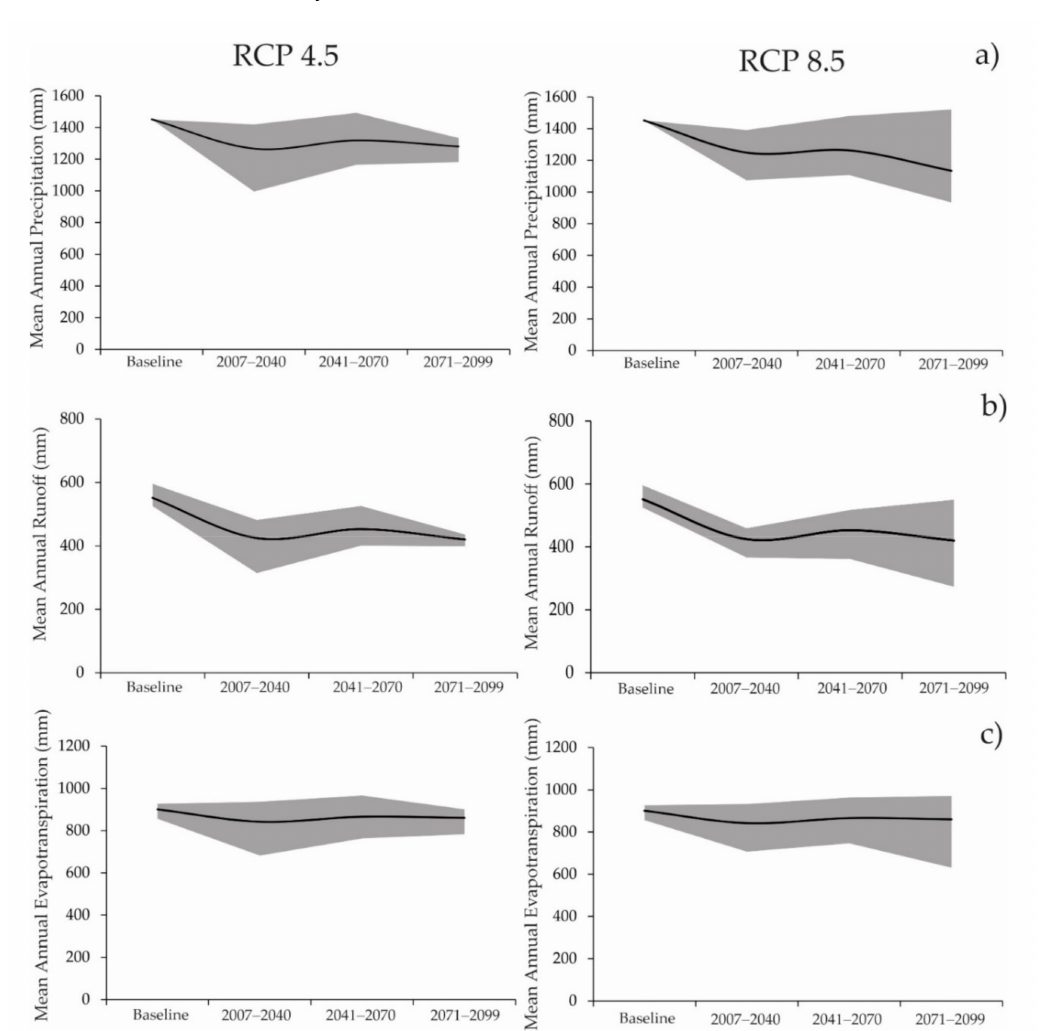
Figure 7. Average annual water balance components for the baseline and time slices simulated by the LASH model forced by the RCMs for the GRB-Furnas basin: ( a ) precipitation, ( b ) runoff, and ( c )